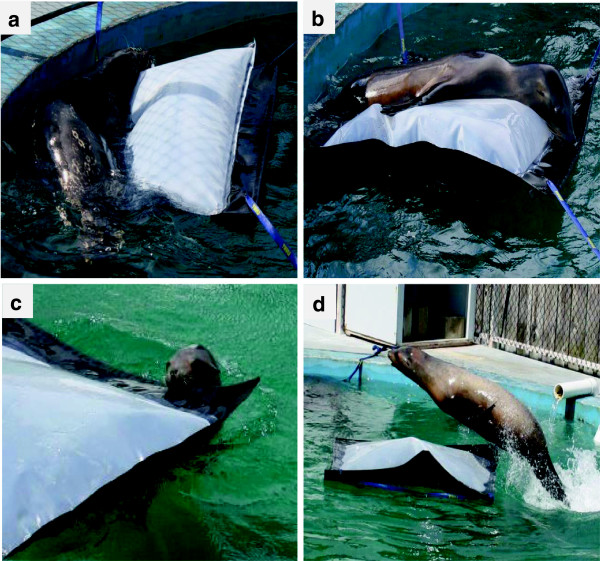
Trained pinnipeds executing operant commands to interact with PBRs tethered in a tank. Hauling out onto the PBR by the harbor seal (Phoca vitulina richardii) (a) and the young sea lion (Zalophus californianus) (b), put stress on the PBR welds. Biting and dragging the PBR by a second older sea lion (c) and jumping over or onto a floating PBR (d) test the durability of its materials and construction.